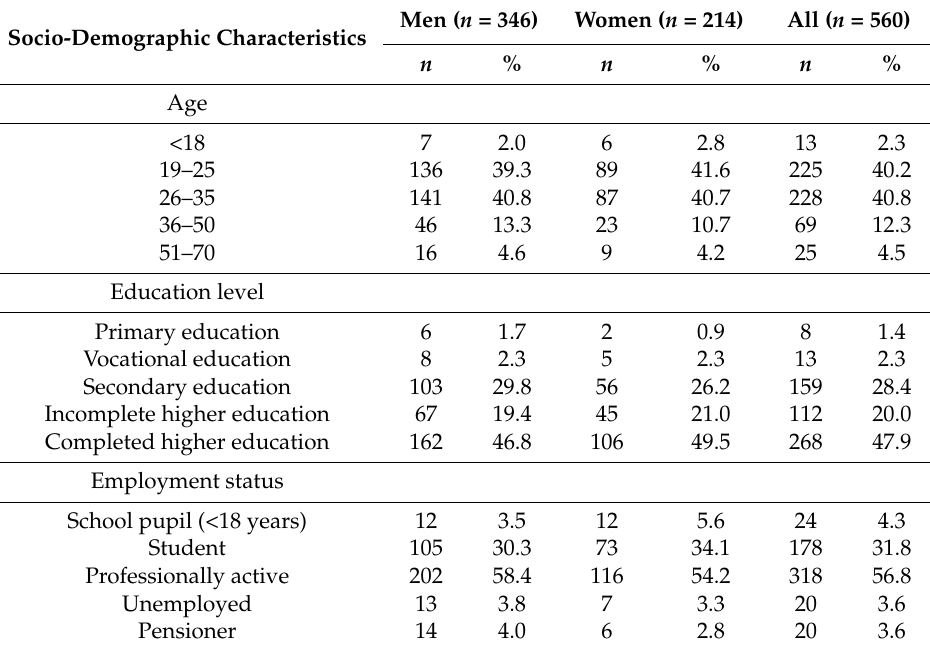
Table 1. Socio-demographic characteristics of